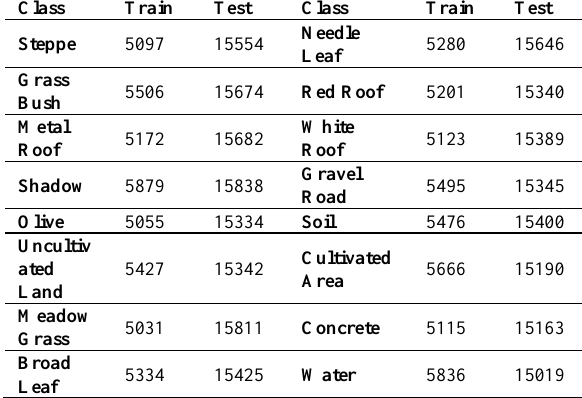
Table 3. Number of training and test data, utilized in the classification process